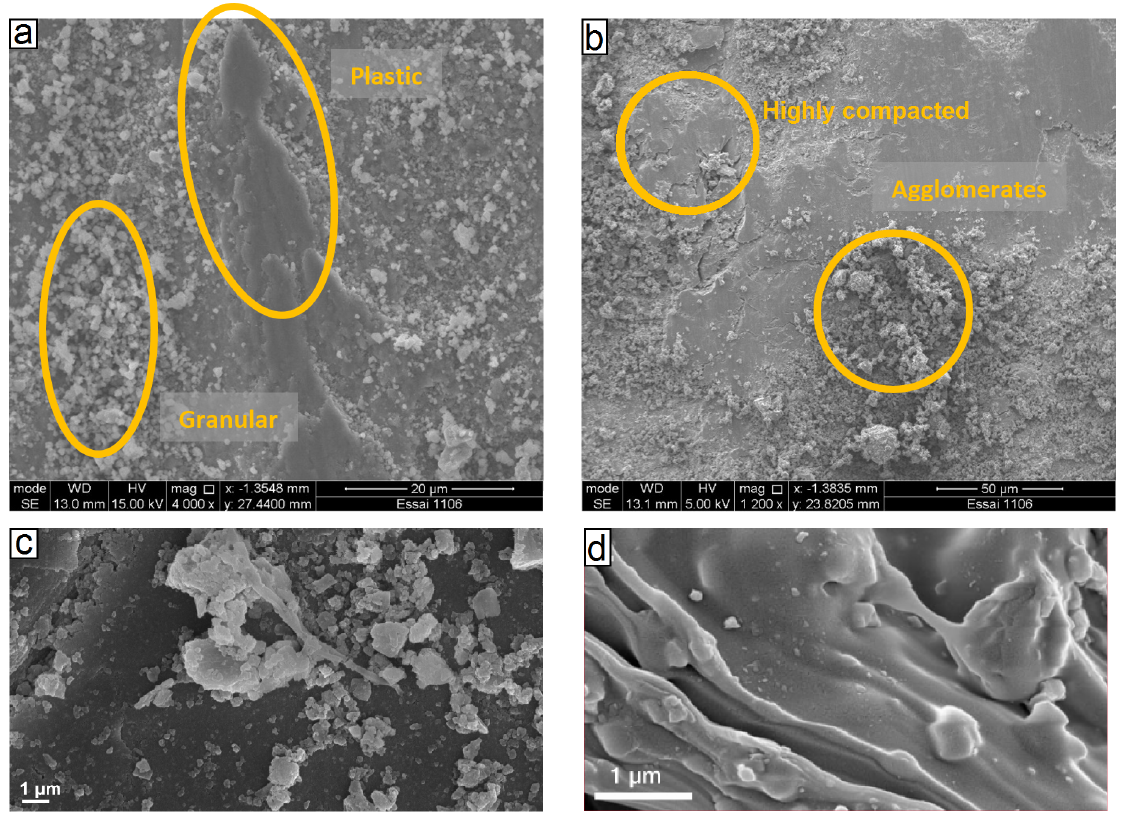
Figure 2: SEM views of tribological third bodies. a : Metal-metal opened contact with evidence of granular and plastic accommodation regimes [27]; b : Same system, evidence of compacted and agglomerated third body; c : Mineral grains of granular gouge in a rock sliding experiment [65]; d : Evidence of gouge melting in a rock sliding experiment